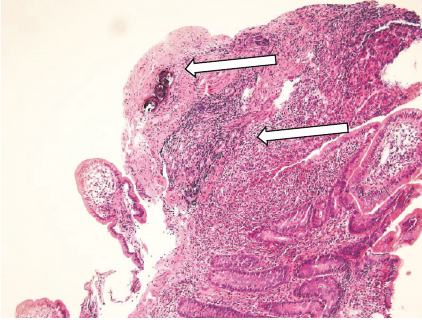
Figure 11: 100x histopathology of jejunal mucosa showing chronic inflammation, ulcerative changes, S. japonicum eggs deposition.